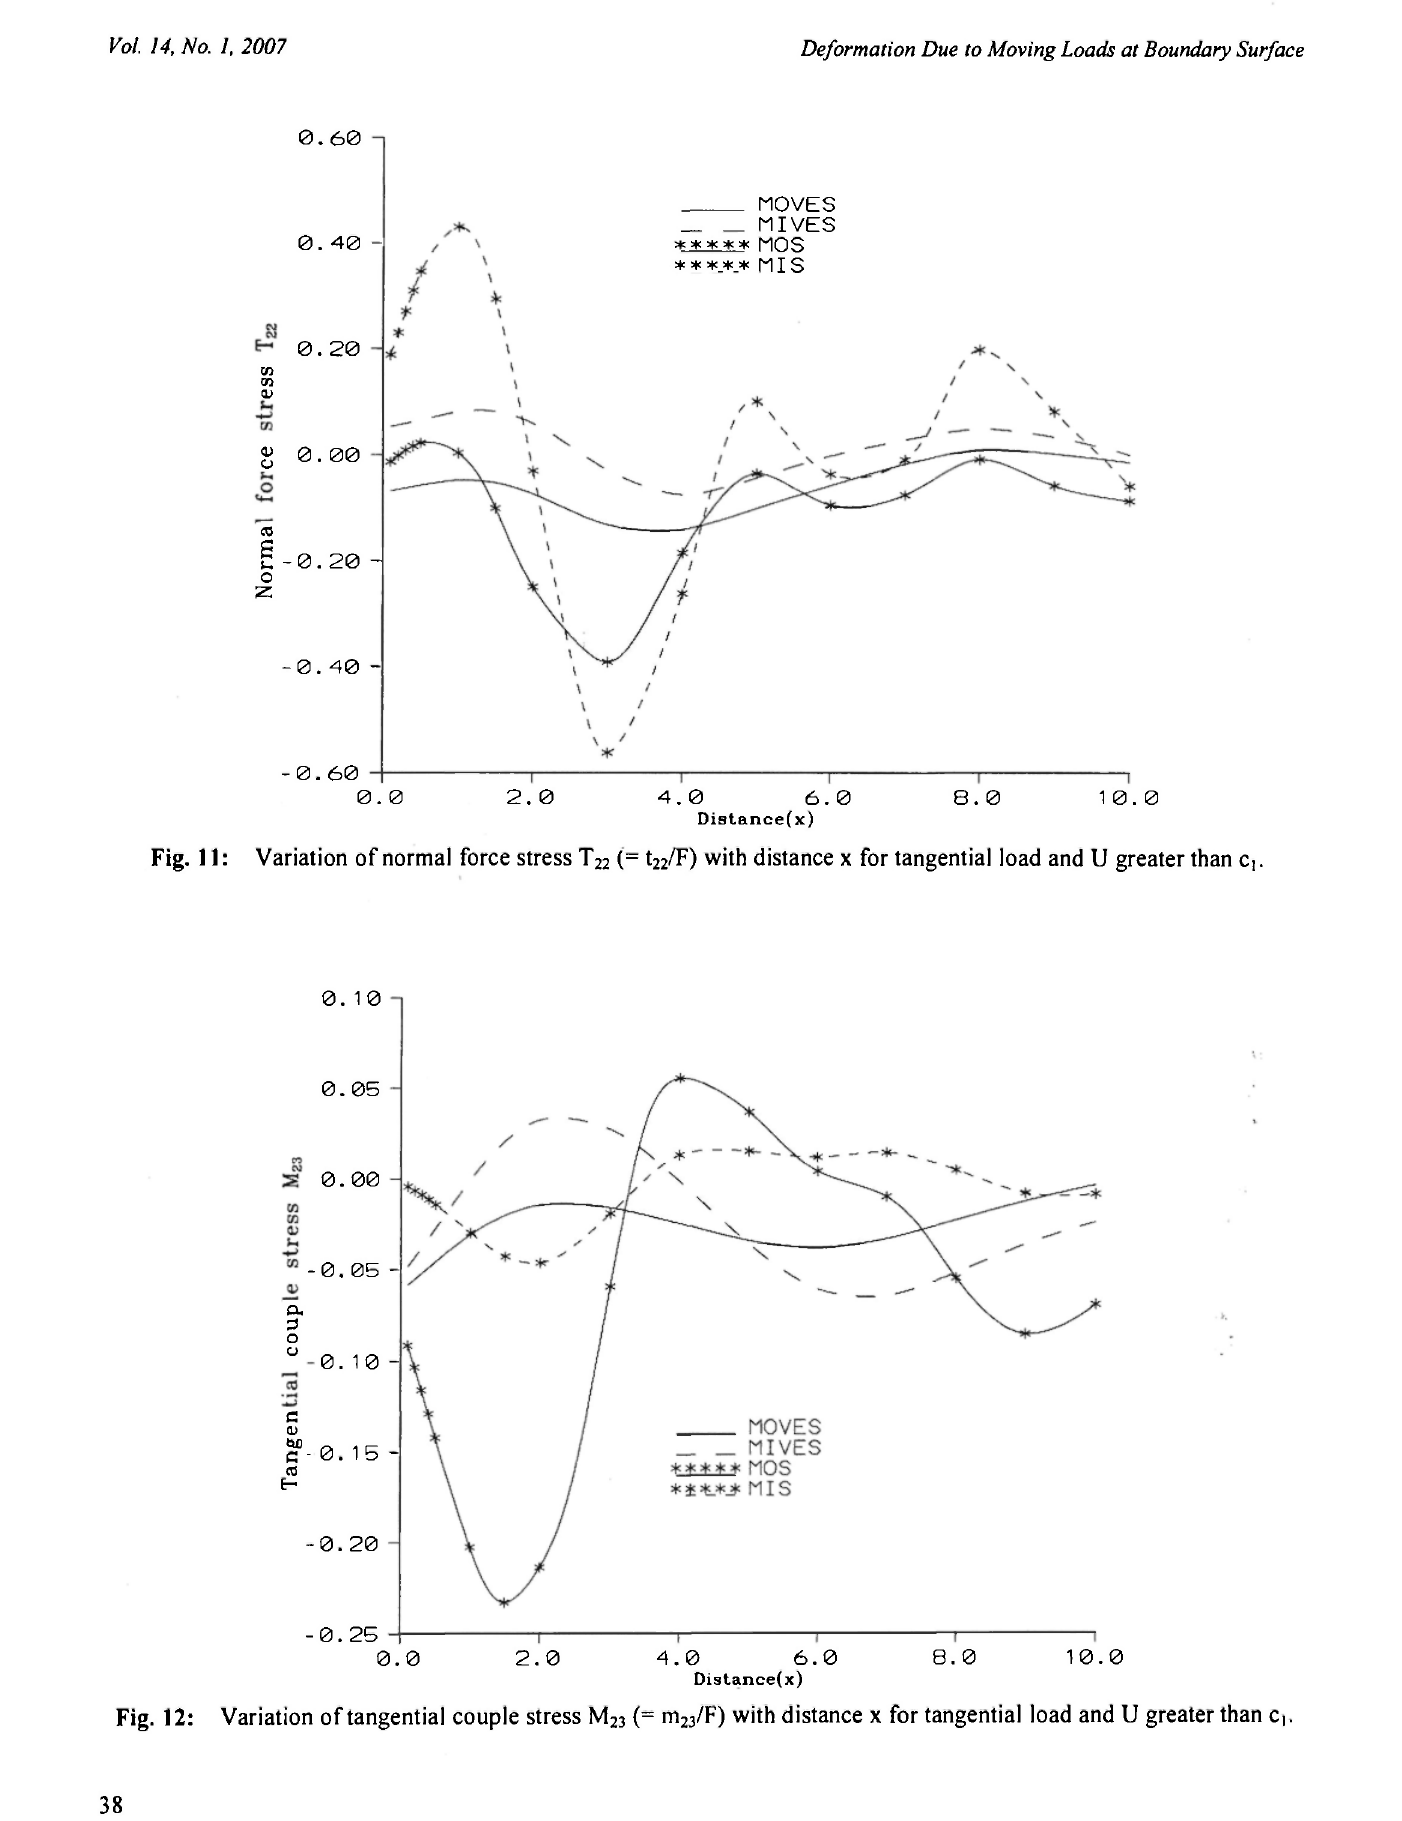
Fig. 12: Variation of tangential couple stress M 23 (= m 23 /F) with distance χ for tangential load and U greater than